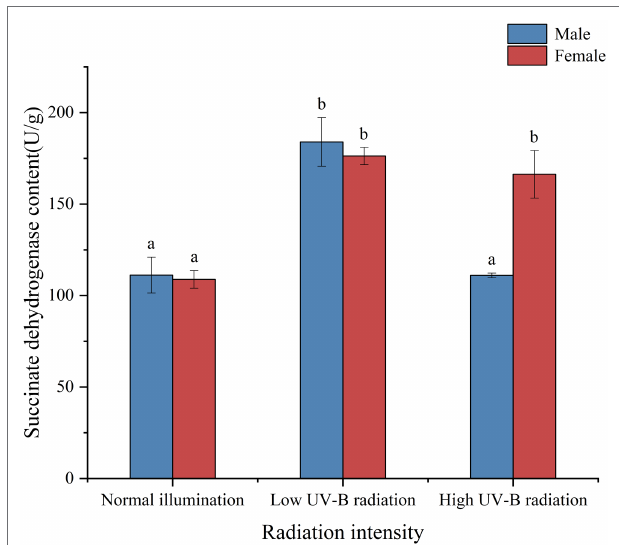
FIGURE 8 | Effect of UV-B on the activities of succinate dehydrogenase in male and female Sargassum thunbergii . And the values represent mean n ± SD ( n = 3). Different letters mean significant differences between male and female Sargassum thunbergii